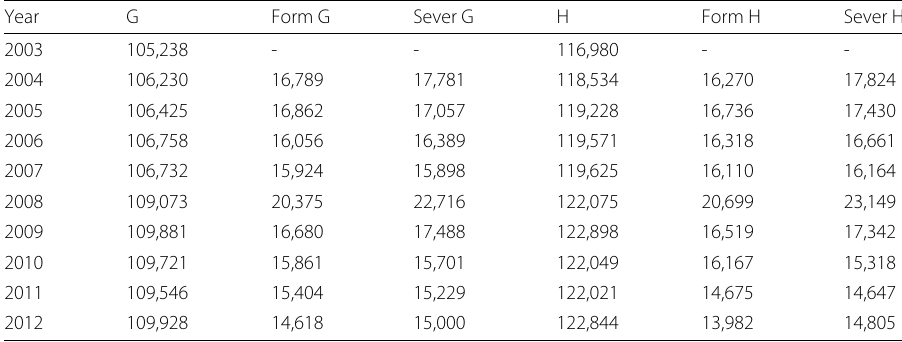
Table 2 Number of nonzero elements in the two adjacency matrices and the number of new links (nonzero elements) formed and severed in the two matrices Year G Form G Sever G H Form H Sever H - 116,980 - -